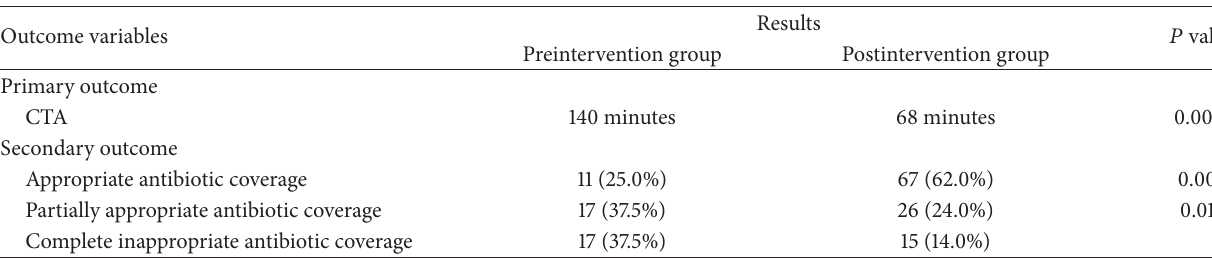
Table 3: Outcome